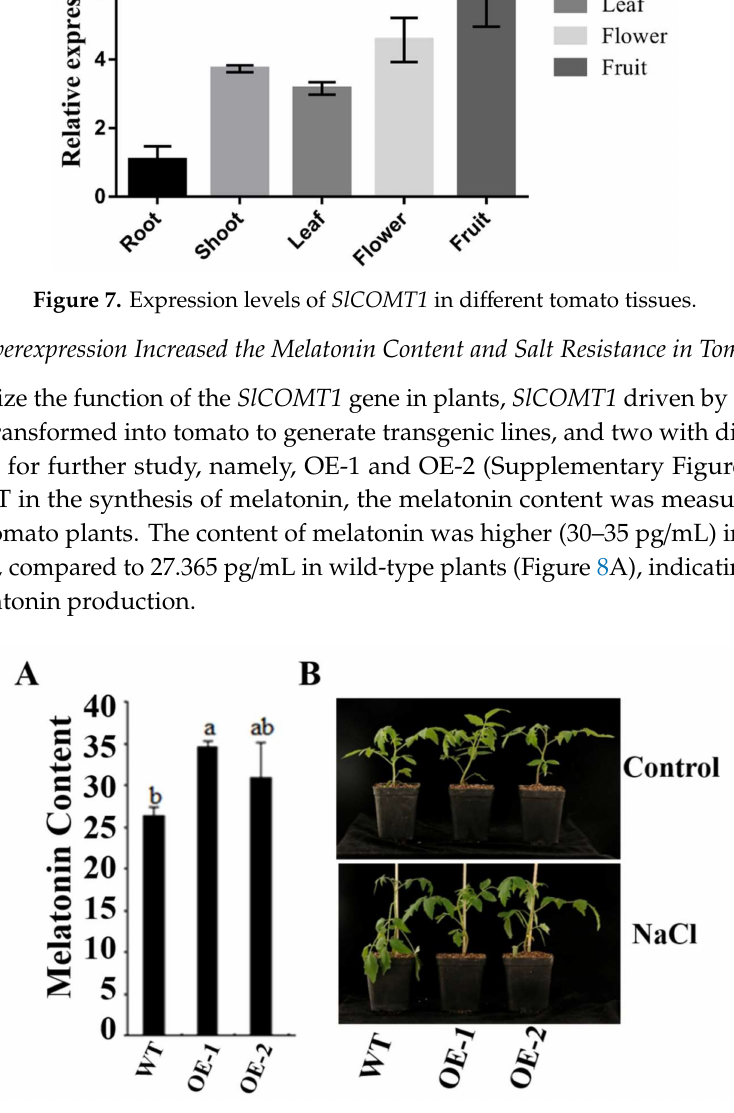
Figure 8. ( A ) Melatonin content in WT, OE-1, and OE-2 tomato plants. The same letter in the same growing season means no significant di ff erences among three biological replicates ( p < 0.05). Error bars represent standard error. ( B ) Growth status of WT, OE-1, and OE-2 after 800 mM NaCl treatment. WT, wild-type; OE, overexpression transgenic